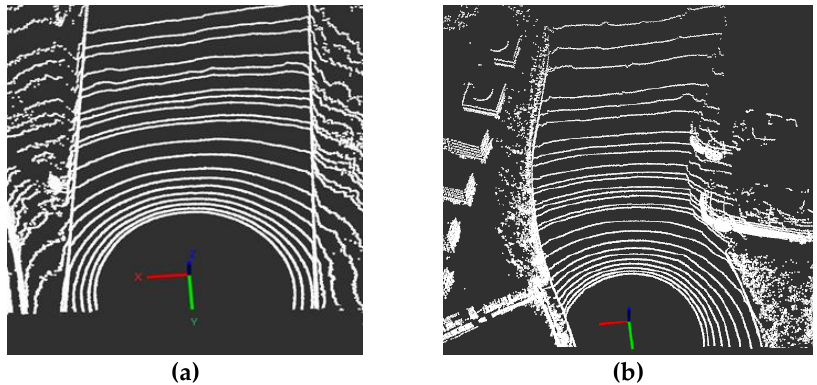
Figure 4. Extraction of foreground point cloud. ( a ) is the extracted foreground point clouds of the straight line. ( b ) is the extracted foreground point clouds of the curve.